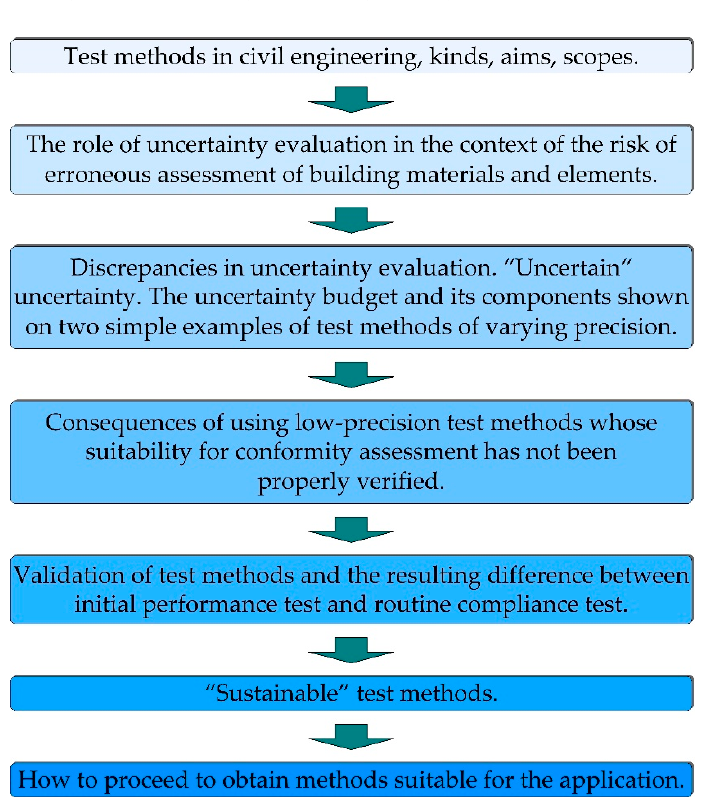
Figure 2. Graphic diagram of the article.